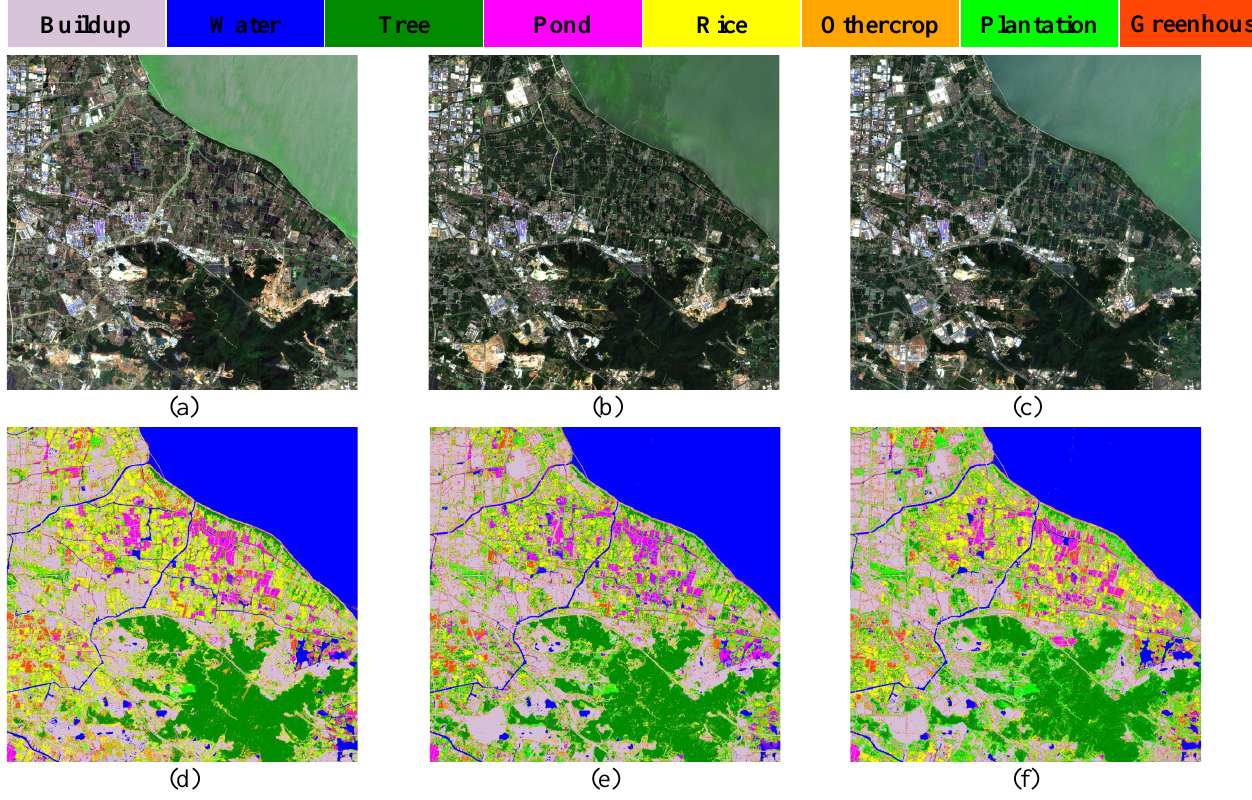
Figure 11. True color maps of the three images ( a ) 2018, ( b ) 2020; and ( c ) 2022; spatial distributions of features in the three images ( d ) 2018; ( e ) 2020; and ( f )